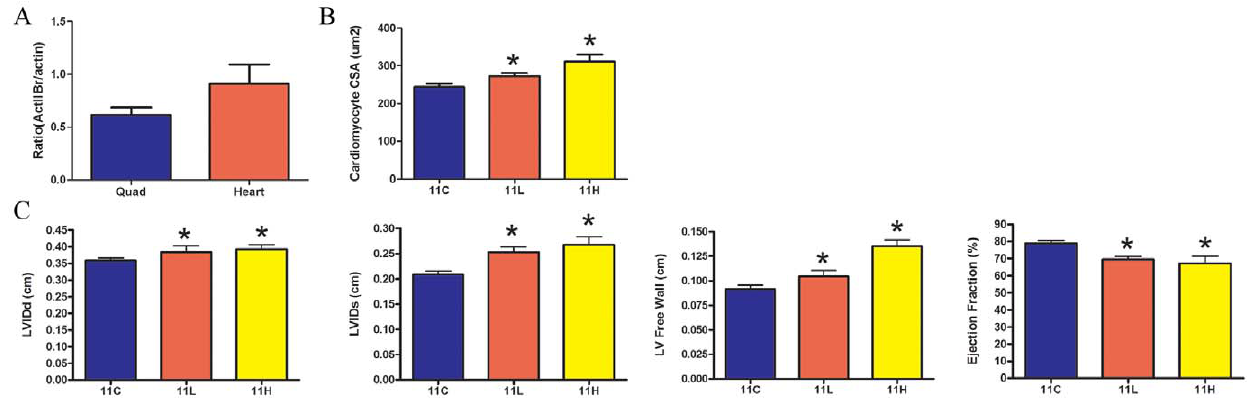
Figure 8. Cardiac properties in long term mdx mice. (a) Protein levels of the activin IIB receptor were similar in the mdx heart and quadriceps. (b) Increased mean cardiomyocyte cross sectional area (CSA) was noted in the mdx 11L and 11H groups. (c) Echocardiography demonstrated increased left ventricle internal diameter during diastole (LVIDd), increased left ventricle internal diameter during systole (LVIDs), increased left ventricle (LV) free wall diameter and decreased ejection fraction in treated animals. There was no difference between the mdx 11L and 11H groups across the reported parameters. Both groups were significantly different from control (11C). Data represent mean 6 SD. *Statistically significant compared to control, p ,